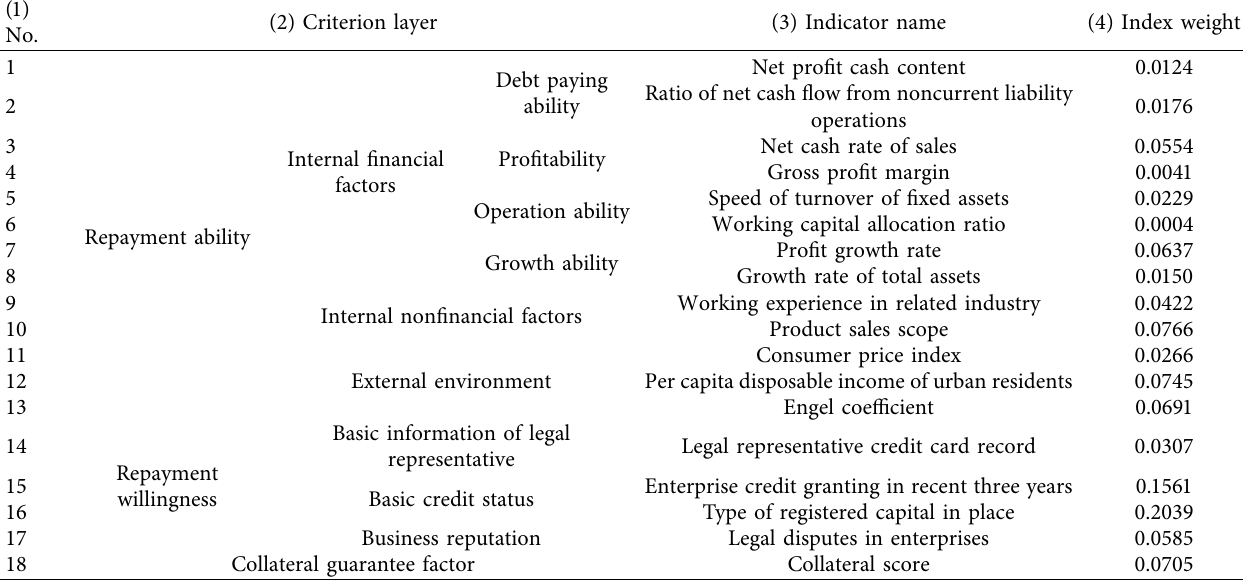
Table 2: Small enterprise credit index system and